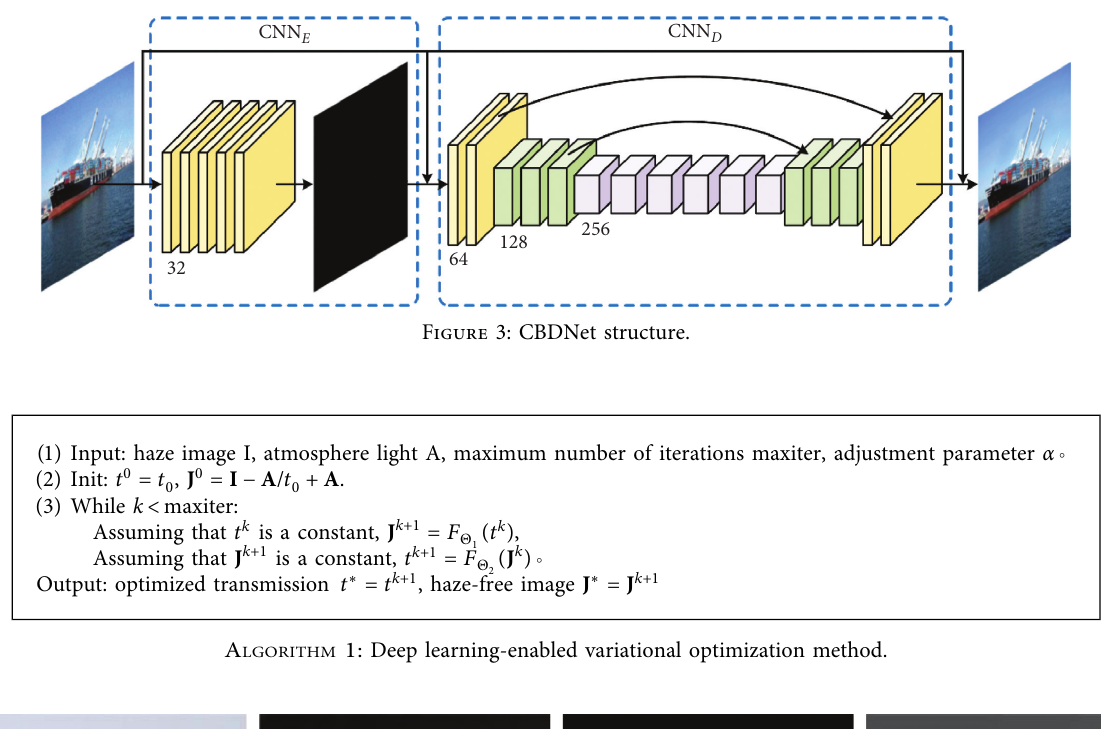
d , (c) weight , (f) optimized transmission t ∗ , (g) dehazing 0